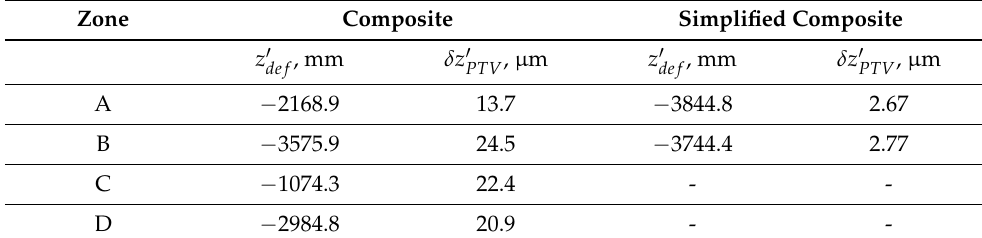
Table 1. Optimized parameters of the recording setup. Zone